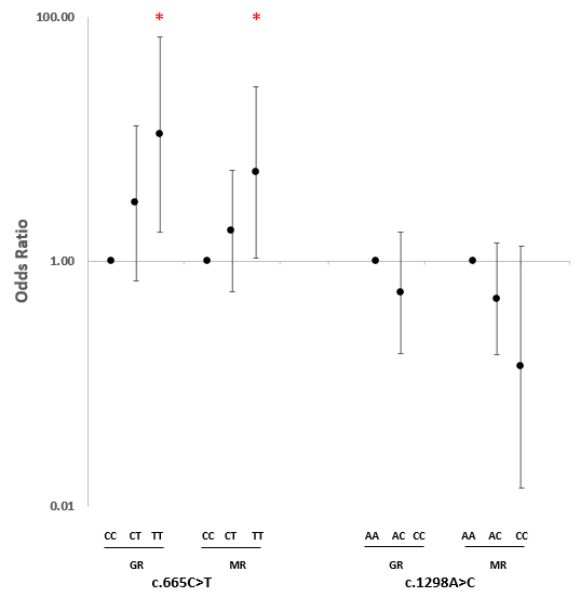
Figure 2. Odds ratio of association of MTHFR c.665C>T and c.1298A>C polymorphisms with the level of response to anti-TNF-α therapy considering wild-type homozygotes as a reference. * Significant nominal p -value. GR: good response; MR: moderate response.